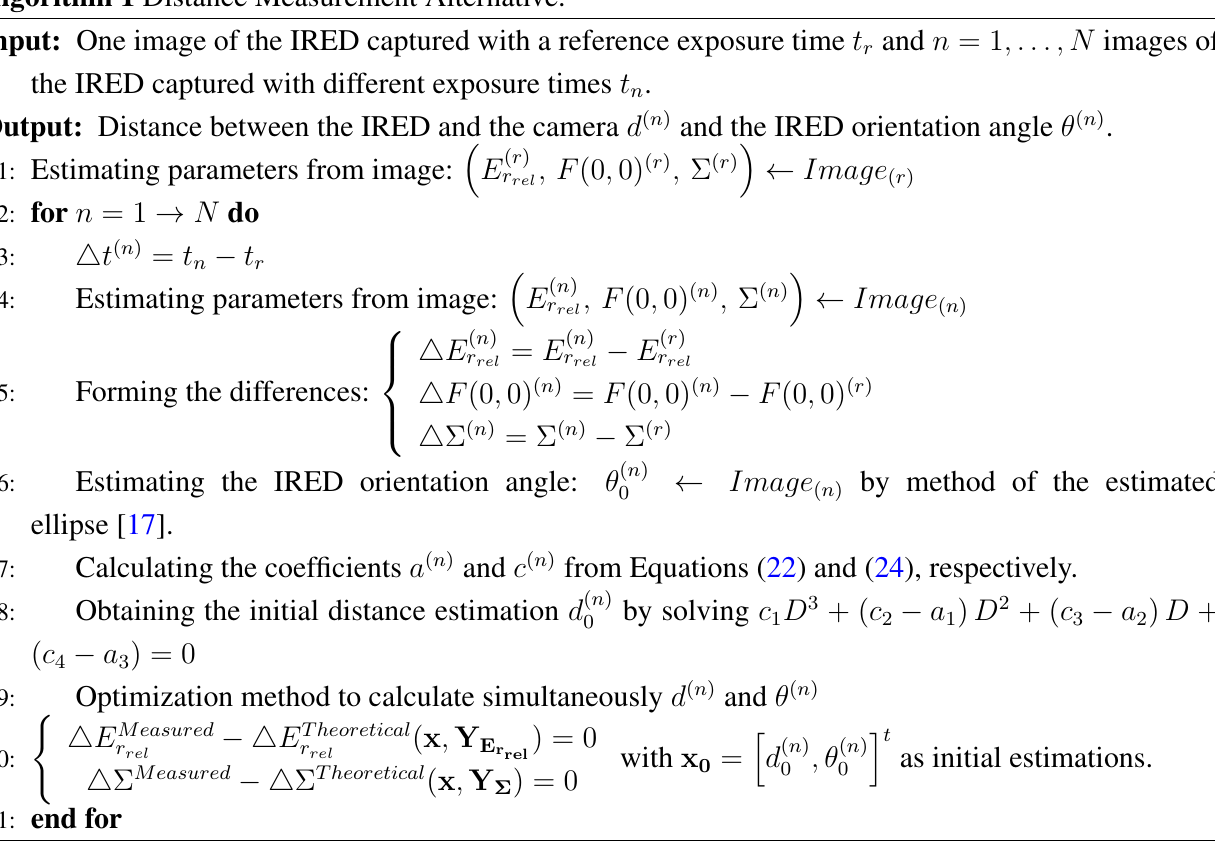
Algorithm 1 Distance Measurement